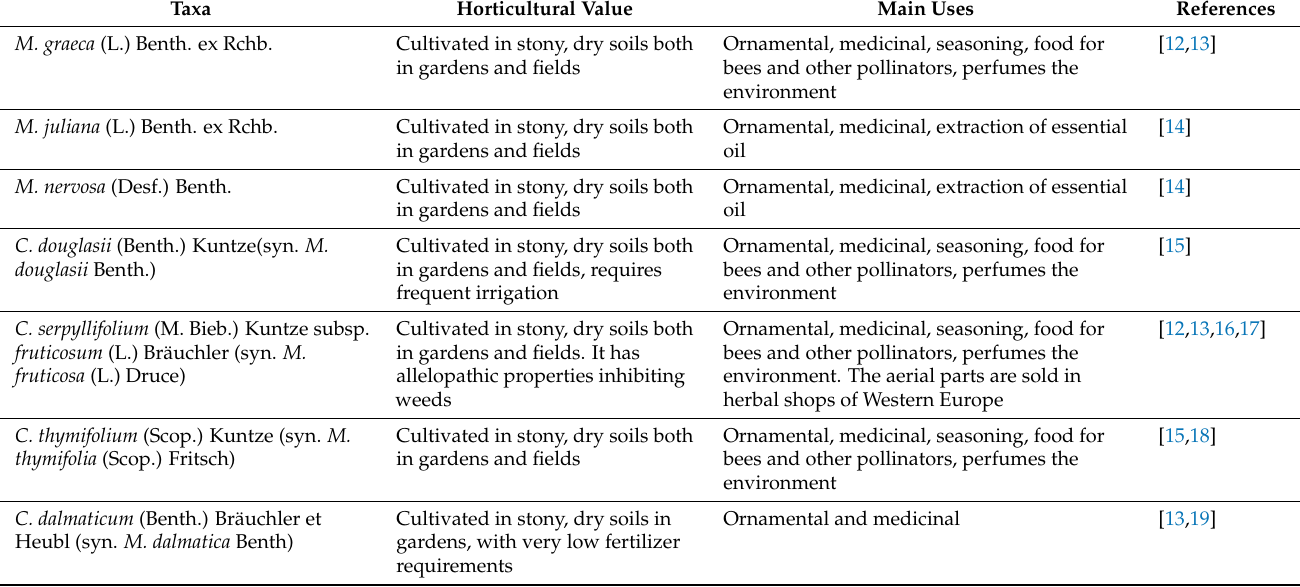
Table 1. Horticultural value of Micromeria ( M .) and closely related Clinopodium ( C. ) species already introduced into